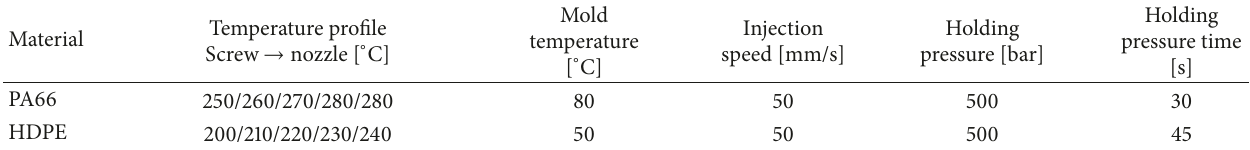
Table 1: Process parameter of injection molding process.